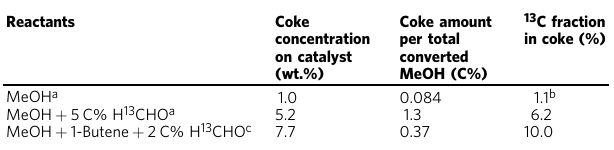
Table 3 Coke concentration and extent of 13 C labelling after 100 min time on stream Reactants Coke